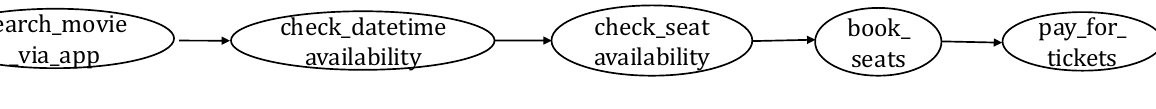
Figure 3: Plan generated by the Planning framework for booking a movie for the